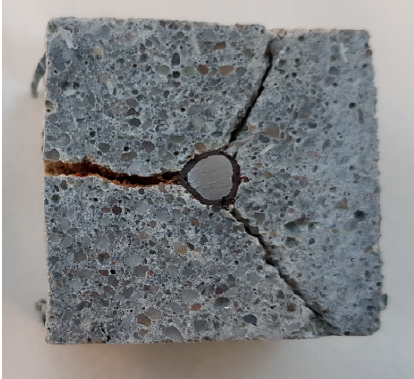
Figure A1. Cross-section of A-24h at the end of conditioning.